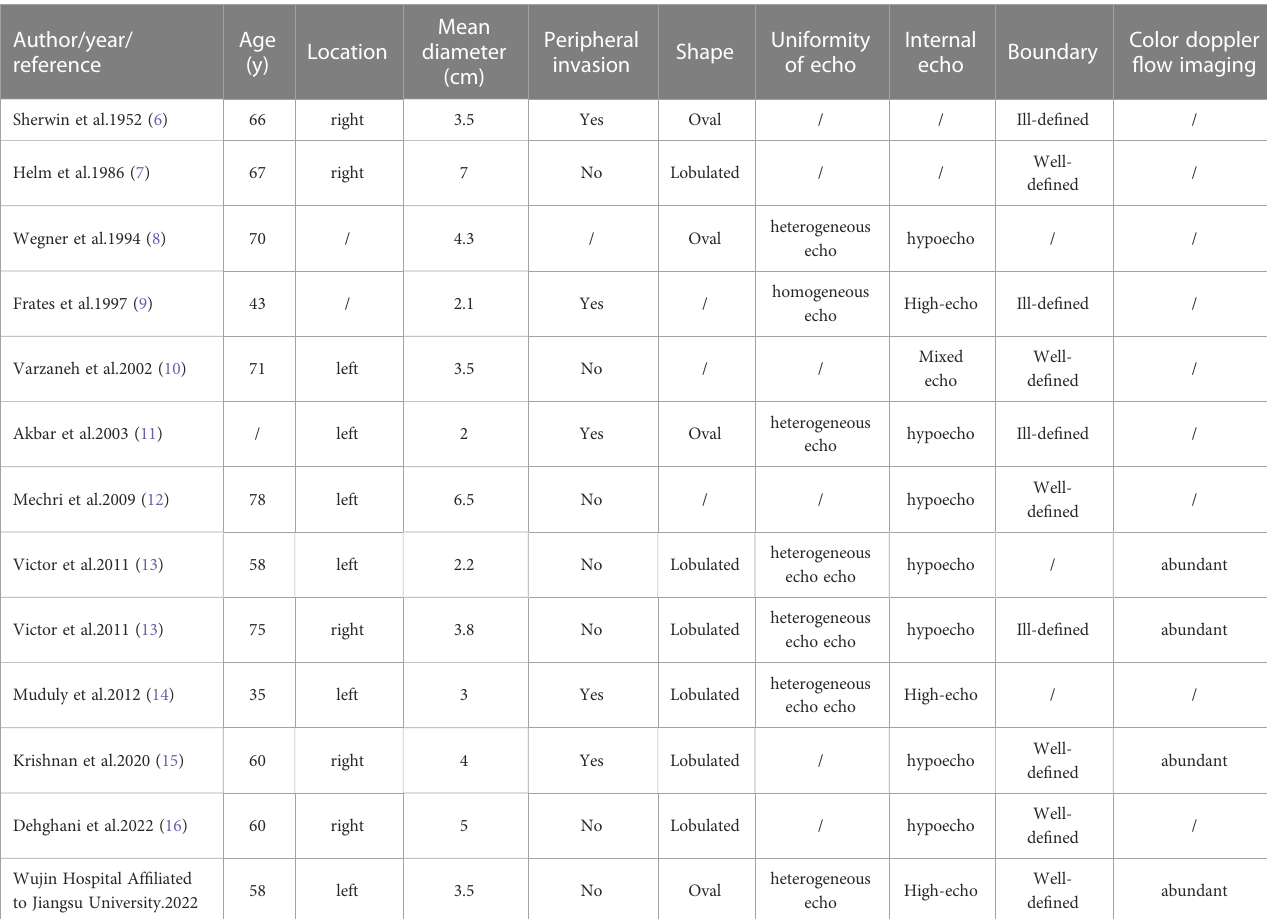
TABLE 1 Patient characteristics of cases reported in the literature and in our